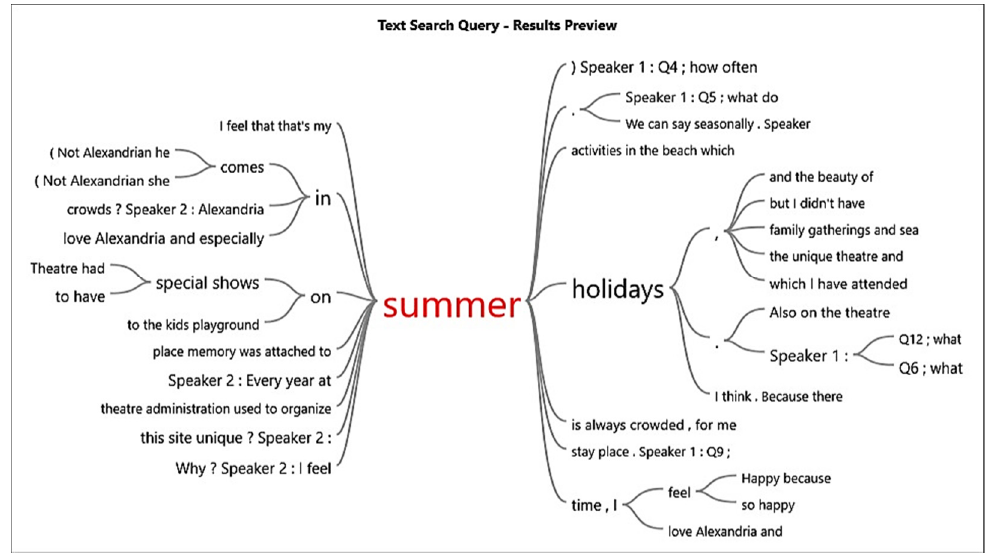
Figure 4. Word tree query, showing the frequency of mentioning summer by the participants, extracted through Nvivo12. Source: F. Hussein. through Nvivo12. Source: F.